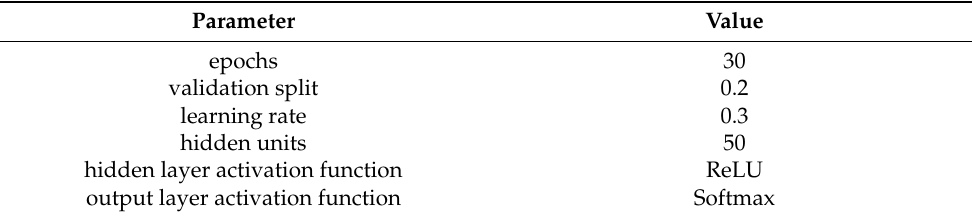
Table 1. Default parameter values.